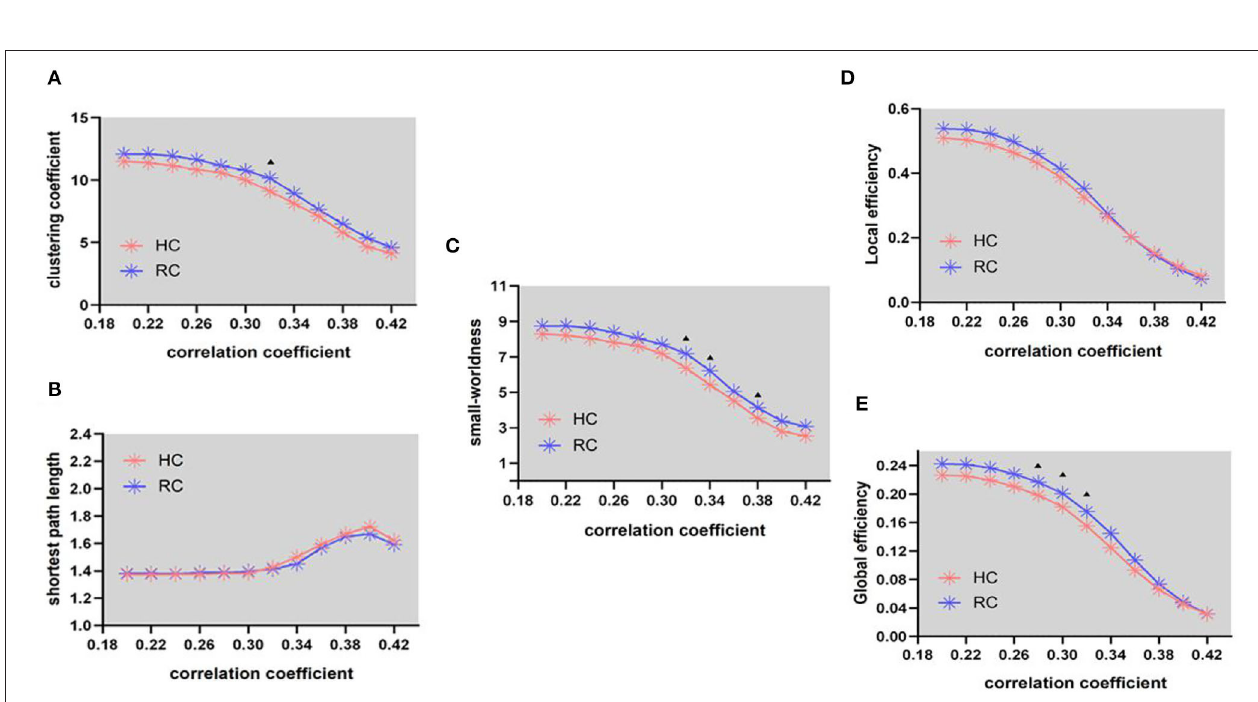
FIGURE 2 | Structural connectivity network at different FA threshold for RC (the blue line) and controls (the pink line) and their statistical comparison results ( p < 0.05 5000 permutation test, FDR correction). (A) Gamma, (B) lambda, (C) sigma, (D) local efficiency, and (E) global efficiency. The black triangles indicate a significant group